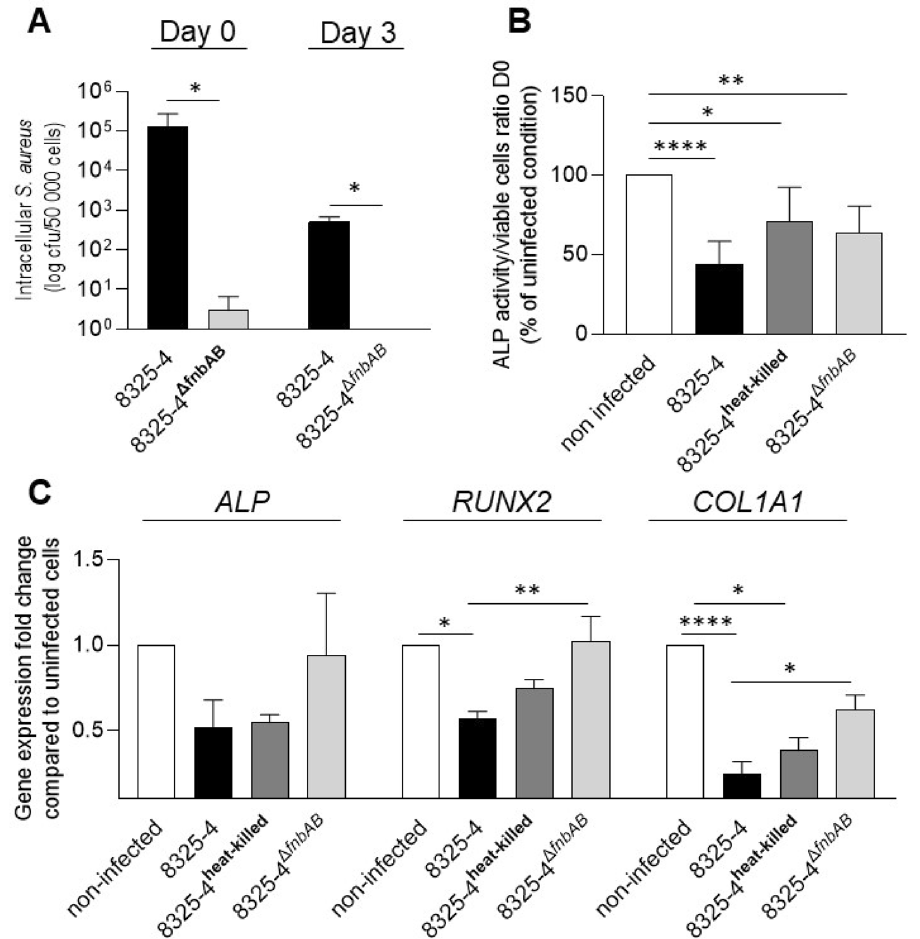
Figure 1. Effect of an infection by 8325–4 S. aureus strains on the early differentiation of OBß1 cells. ( A ) Quantification of internalization and intracellular survival of S. aureus 8325–4 and 8325–4 ∆ fnbAB into OBß1 osteoblasts. ( B ) Effect of S. aureus 8325–4, 8325-4 heat killed and 8325–4 ∆ fnbAB on ALP activity. Results are expressed as a proportion of the activity detected for the non-infected condition. ( C ) Effect of S. aureus 8325–4, 8325- 4 heat killed and 8325–4 ∆ fnbAB on the expressions of ALP , RUNX2 , COL1A1 , expressed as a fold change compared to the non-infected condition. At least 2 independent experiments in technical duplicates were performed. *, ** or **** mean P < 0.05, P < 0.01 and P < 0.0001